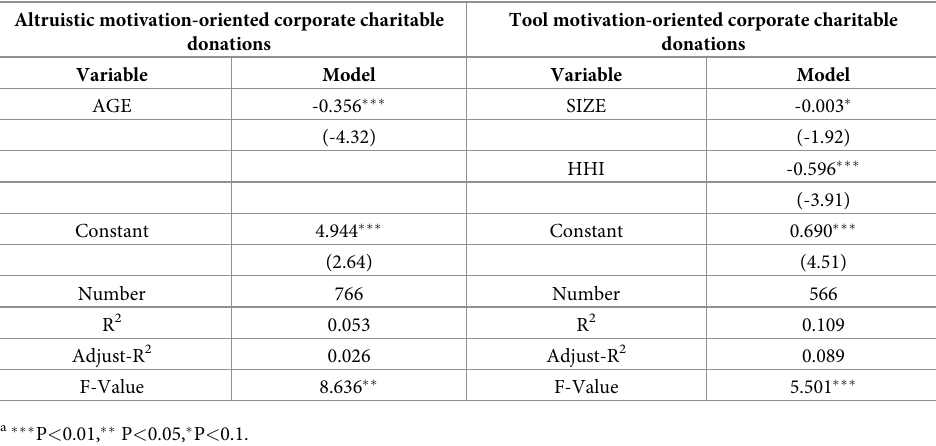
Table 1. Regression results of endogenous control variables.